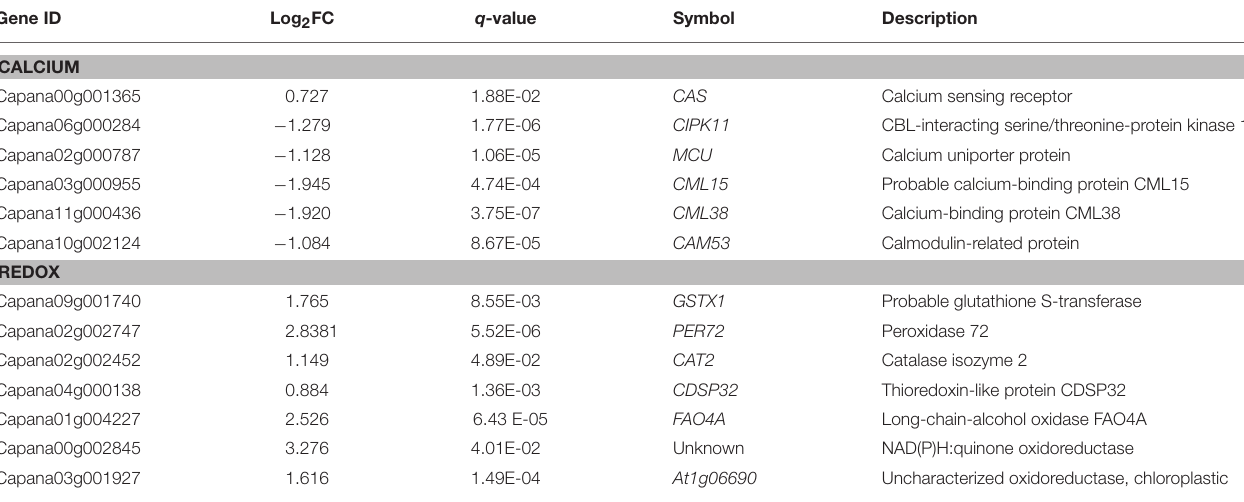
TABLE 6 | Calcium signaling and redox-related genes expression in pepper leaves as influenced by chilling alone or in combination EBR treatment. Gene ID